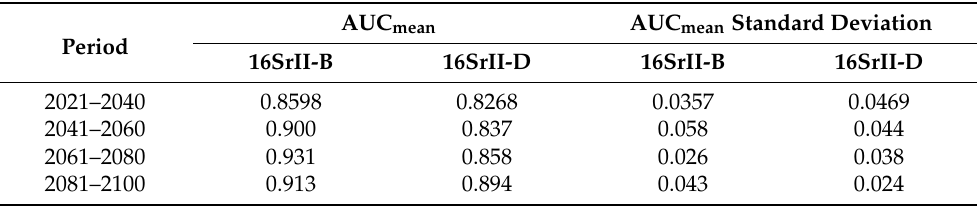
Table 3. AUC values of II-B and II-D modeling distribution from various climate-change scenarios.